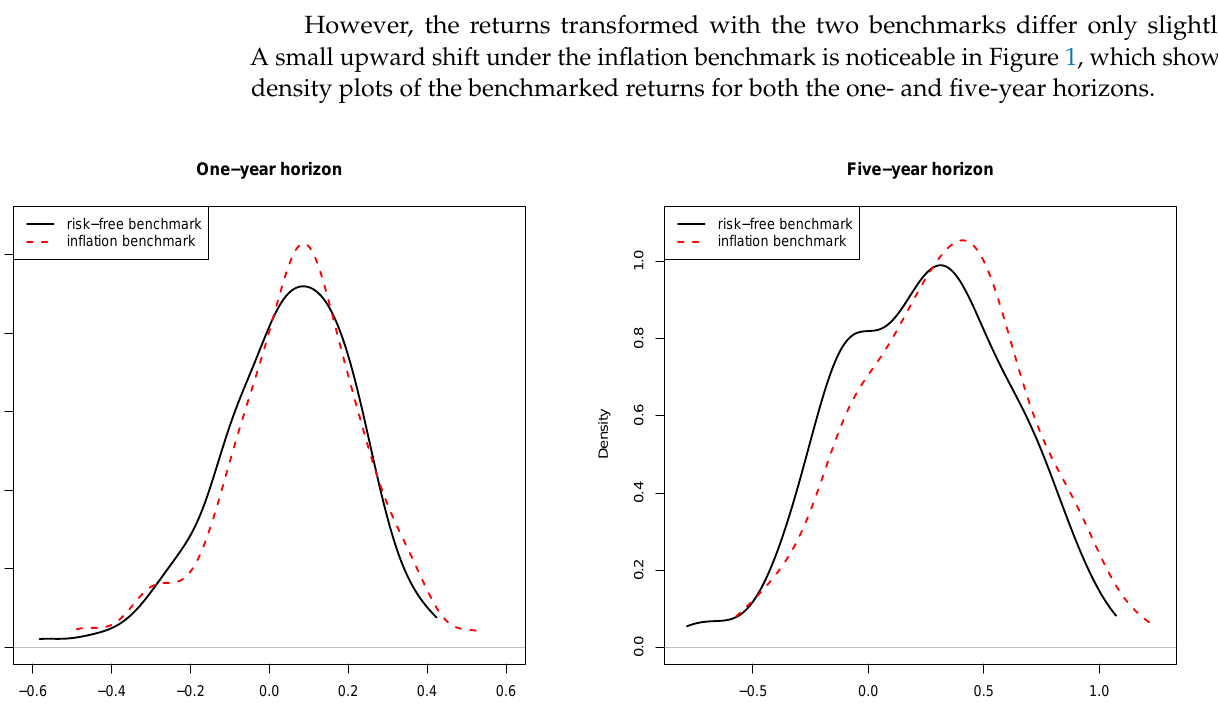
Figure 1. Kernel density estimates of the probability density function of returns transformed with the risk-free rate benchmark (solid) and the inflation benchmark (dotted). ( Left ) One-year horizon. ( Right ) Five-year horizon.